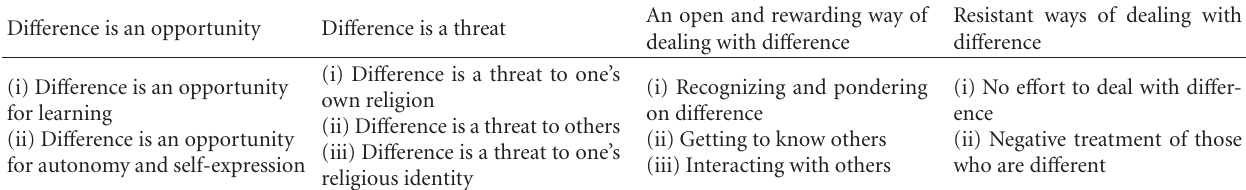
Table 2: Ways of perceiving and dealing with di ff erence related to the negotiation of post-modern ideals. Di ff erence is an opportunity Di ff erence is a